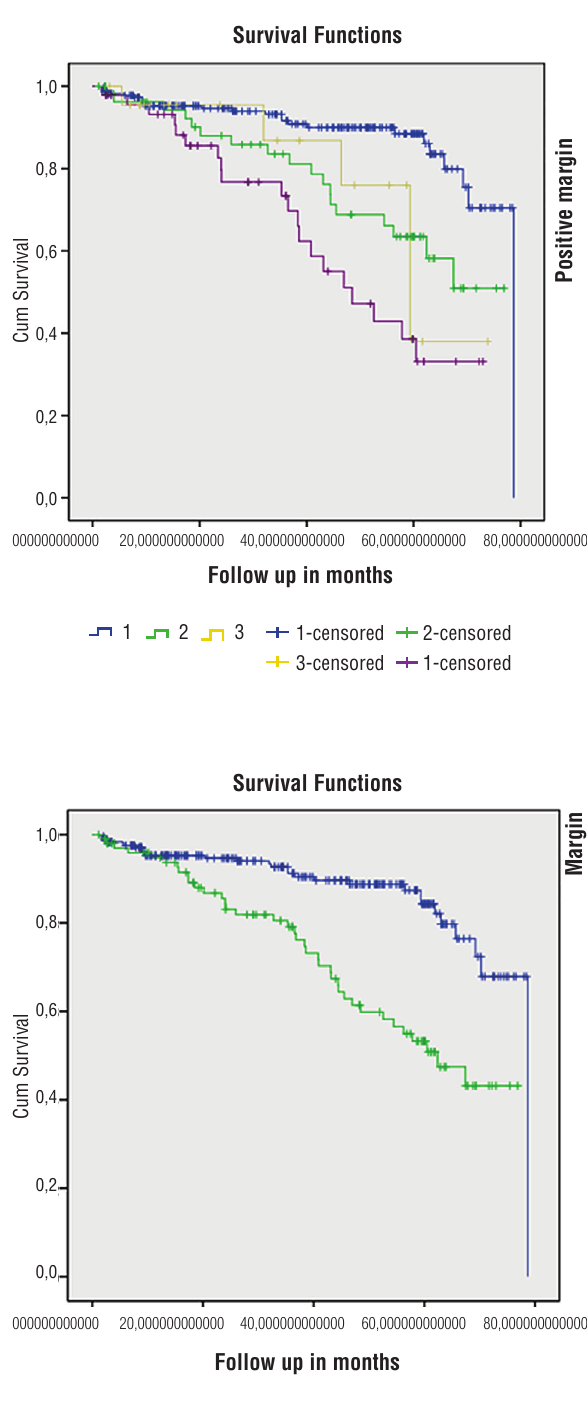
Figure 2 - A) Kaplan Meier curve showing biochemical recurrence for tumors 1. pT2R0; 2. pT2R1; 3. pT3R0 and 4. pT3R1. B) Kaplan Meier curve showing biochemical recurrence for tumors 0. Negative margin 1. Positive